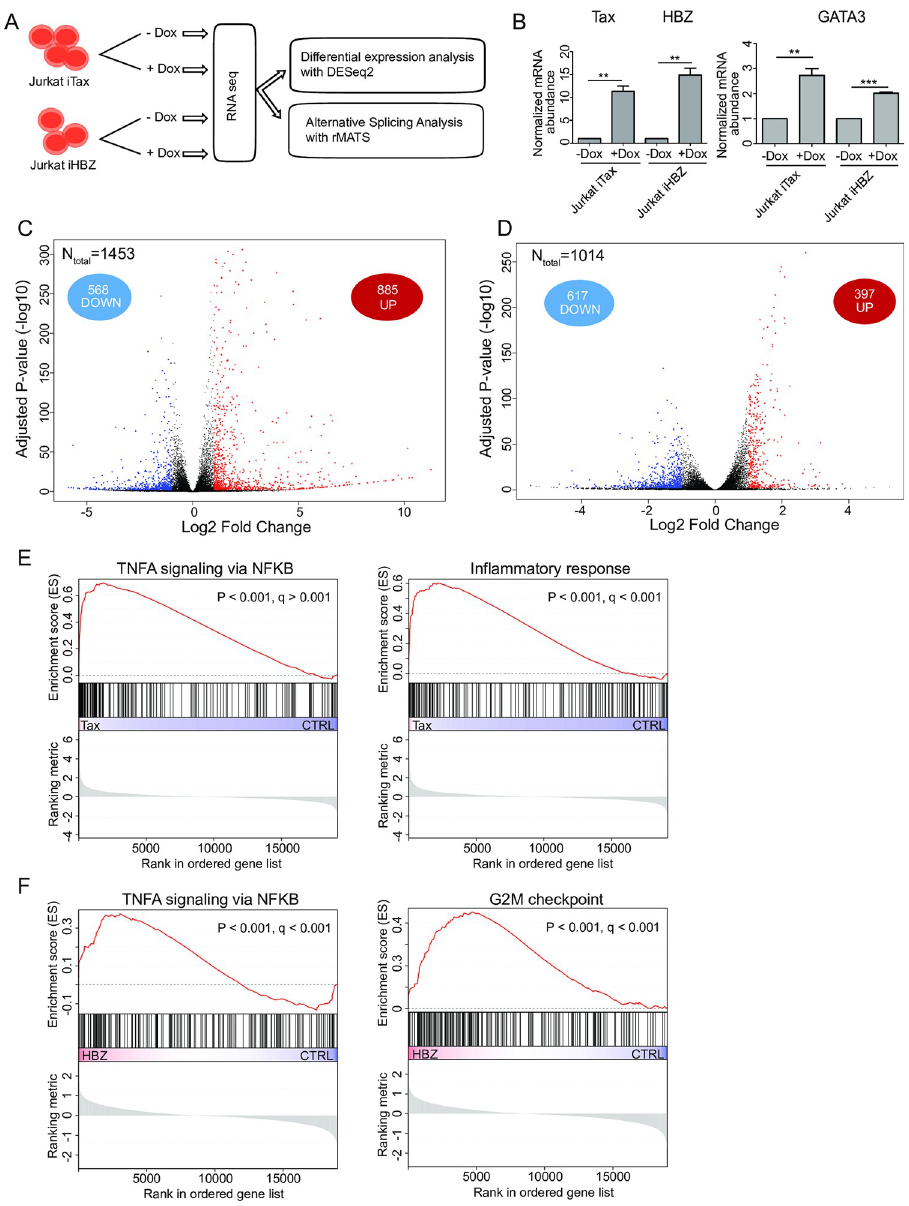
Fig 2. A comparative analysis of transcriptomic changes associated with Tax and HBZ expression. (A) Overview of the experimental design for analysis of abundance and splicing alterations upon Tax and HBZ expression in Jurkat cells. Three replicates of each condition were used for RNA seq analysis. (B) Tax and HBZ expression was analyzed by qRT-PCR in Jurkat cells after induction with doxycycline (left). Overexpression of GATA3 in Jurkat-iTax and Jurkat- iHBZ cell lines (right). �� = p-value < 0.01, ��� = p-value < 0.001 (C-D) Volcano plot of significantly up-regulated genes (red dots) and down-regulated genes (blue dots) upon induction of Tax (C) or Flag-HBZ (D) in Jurkat cells. (E-F) Examples of significantly enriched gene sets by GSEA in Jurkat-iTax (E) cells and Jurkat-iHBZ (F) cells. See also S2 Data. gene expression regulation, respectively (S3 Fig). To assess the impact of Tax and HBZ on the cellular splicing landscape, we statistically computed splicing events using the rMATS software (Fig 3A, [46]). We focused on 5 types of alternative splicing: Skipped Exons (SE) or cassette